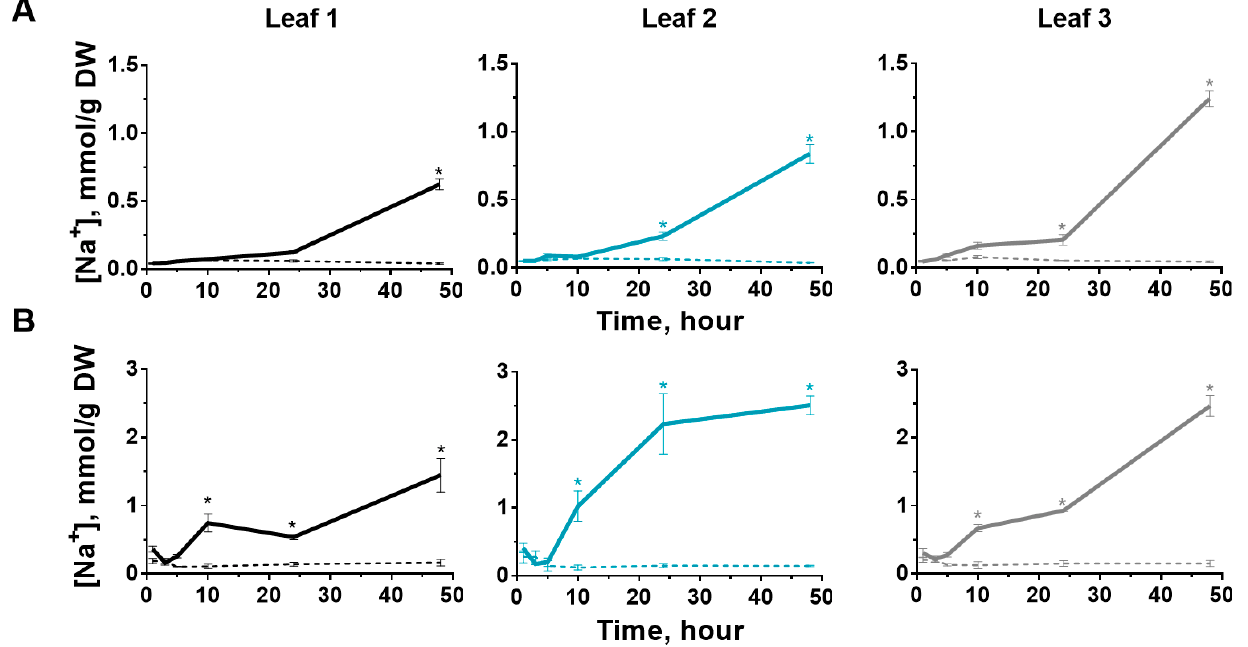
Figure 7. Changes in the sodium content in leaves of tobacco ( A ) and potatoes ( B ) (control—dotted, salinity—solid). The data are presented as mean ± SEM (n = 6), * p < 0.05 control versus salt treatment.